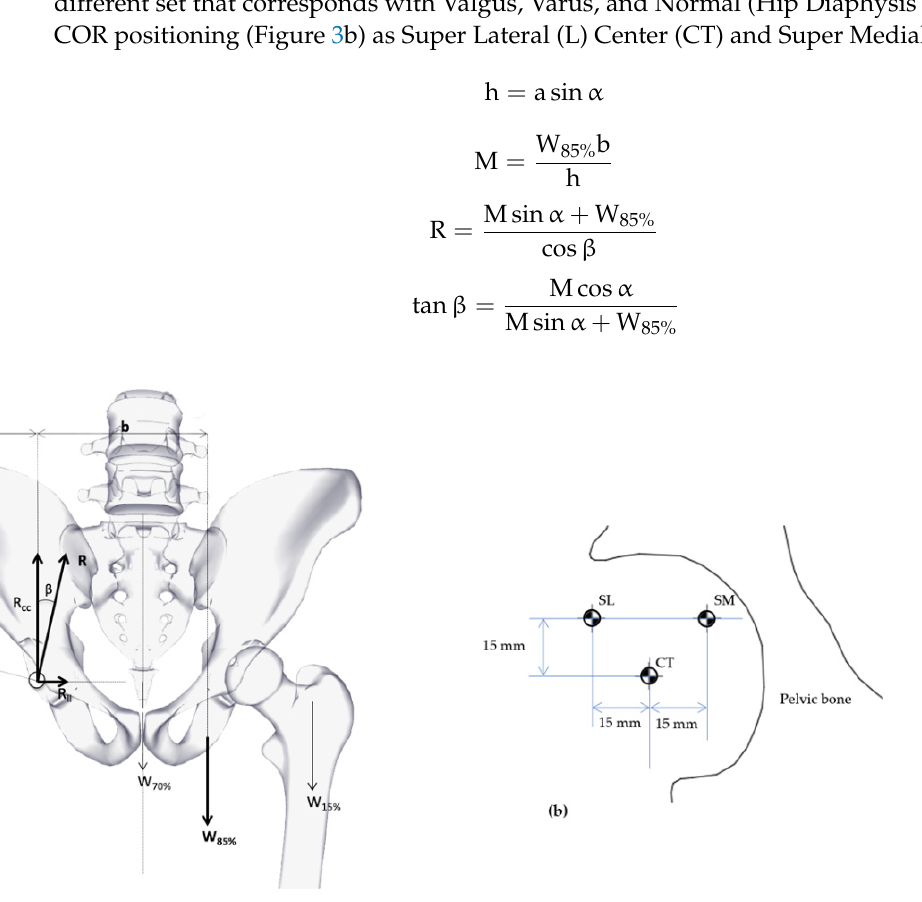
Figure 3. ( a ) Biomechanics diagram forces over hip (frontal projection). ( b ) Displacement for CT, SL, SM as COR position- ing. As is shown in Table 1 (c), the gluteus medius vector angle ( α ) is fixed in each group of values for the three cervical–diaphyseal angles and stems from the geometrical struc- ture of the varus hip (19º below the average value) and valgus hip (7° above the standard value) when the angle is varied [31,32] from 71°.a = 68 mm, given from Le Veau [33]. As aforementioned, specific vector loads were applied over the inner side of the lin- ers depending on their cervical–diaphyseal angle and COR positioning (Table 1 (c)). These loads, which depict the femoral head sphere, were distributed (Figure 2b) all over the cir- cle area, and the dimensions were previously calculated from Hertz contact theory. This area is the contact surface between the ball femoral head and the inner side of the liner and implies a significant reduction of time computed to obtain a desirable order of mag- nitude in the outcomes. Finally, a cemented acetabular fixation was configurated over the models (ABT ge- ometry) through a complete restriction (Figure 4b) of movements (no displacements on or turns around three spatial axes) of the outer surface including the rim of the liner. The other condition (uncemented) was succeeded by partial rim restriction and the middle fit mechanism on the shell (Figure 4a) with G7 geometry. This kind of restriction avoids non- linearity created by possible friction contacts if we consider a shell material. To sum up, this research considers the shell and bone mechanical properties, applying these specific boundary conditions over the liner geometry (G7 and ABT). The inner geometry is the same in both cases, but the outer geometry is different.